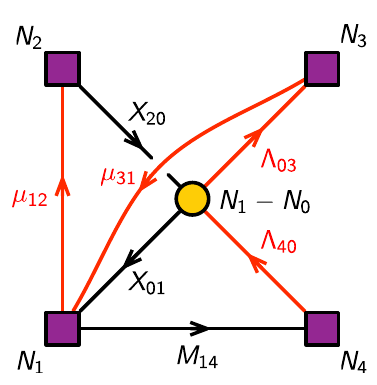
Figure 6 . Quiver diagram for T 0 , the quadrality dual of the theory in (cid:12)gure